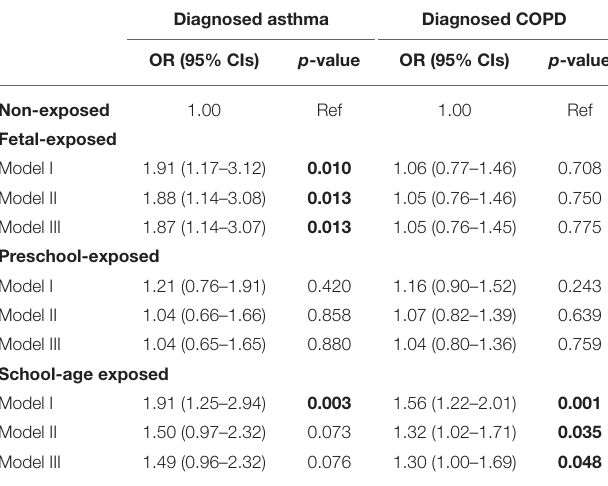
TABLE 2 | Crude and adjusted odds ratio for the association between early-life exposure to Chinese famine and risk of self-reported diagnosed asthma and COPD in